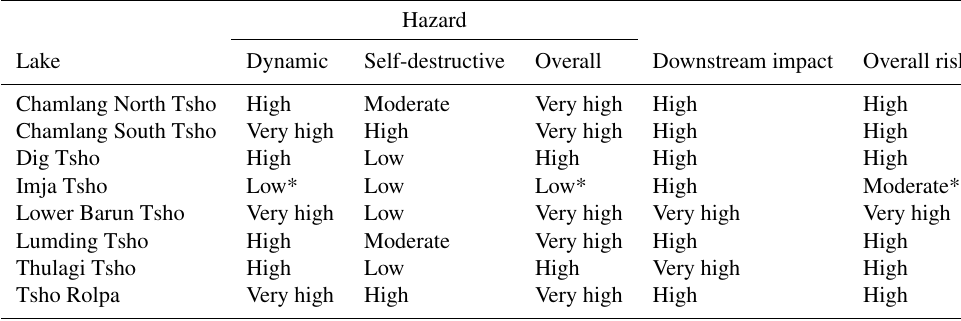
Table 6. Summary of hazard, downstream impact, and risk for each glacial lake.